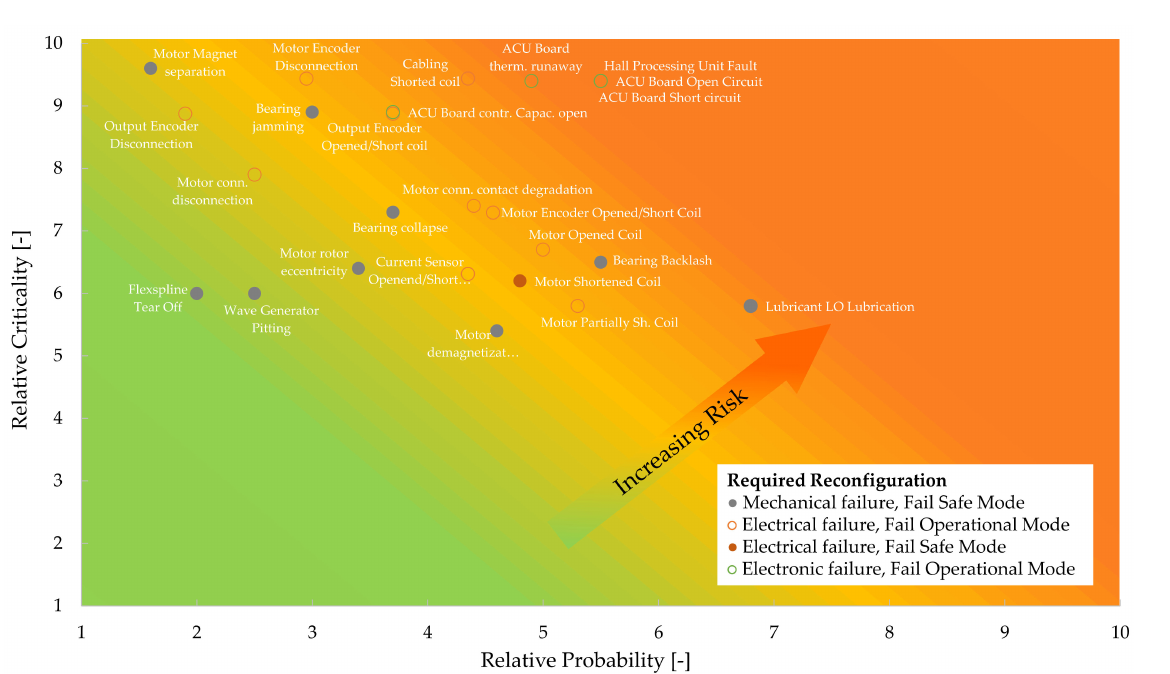
Figure 4. Qualitative risk analysis of different EMA failure modes